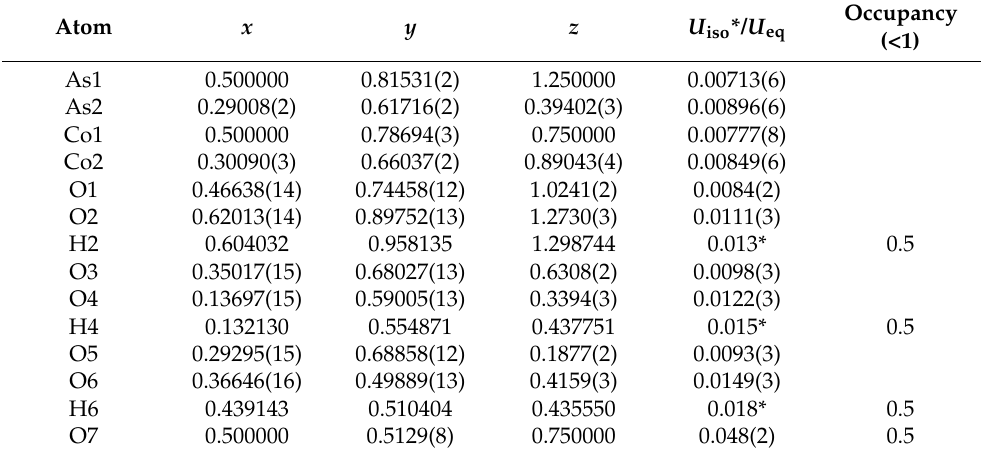
Table 2. Fractional atomic coordinates and isotropic or equivalent displacement parameters (Å 2 ).